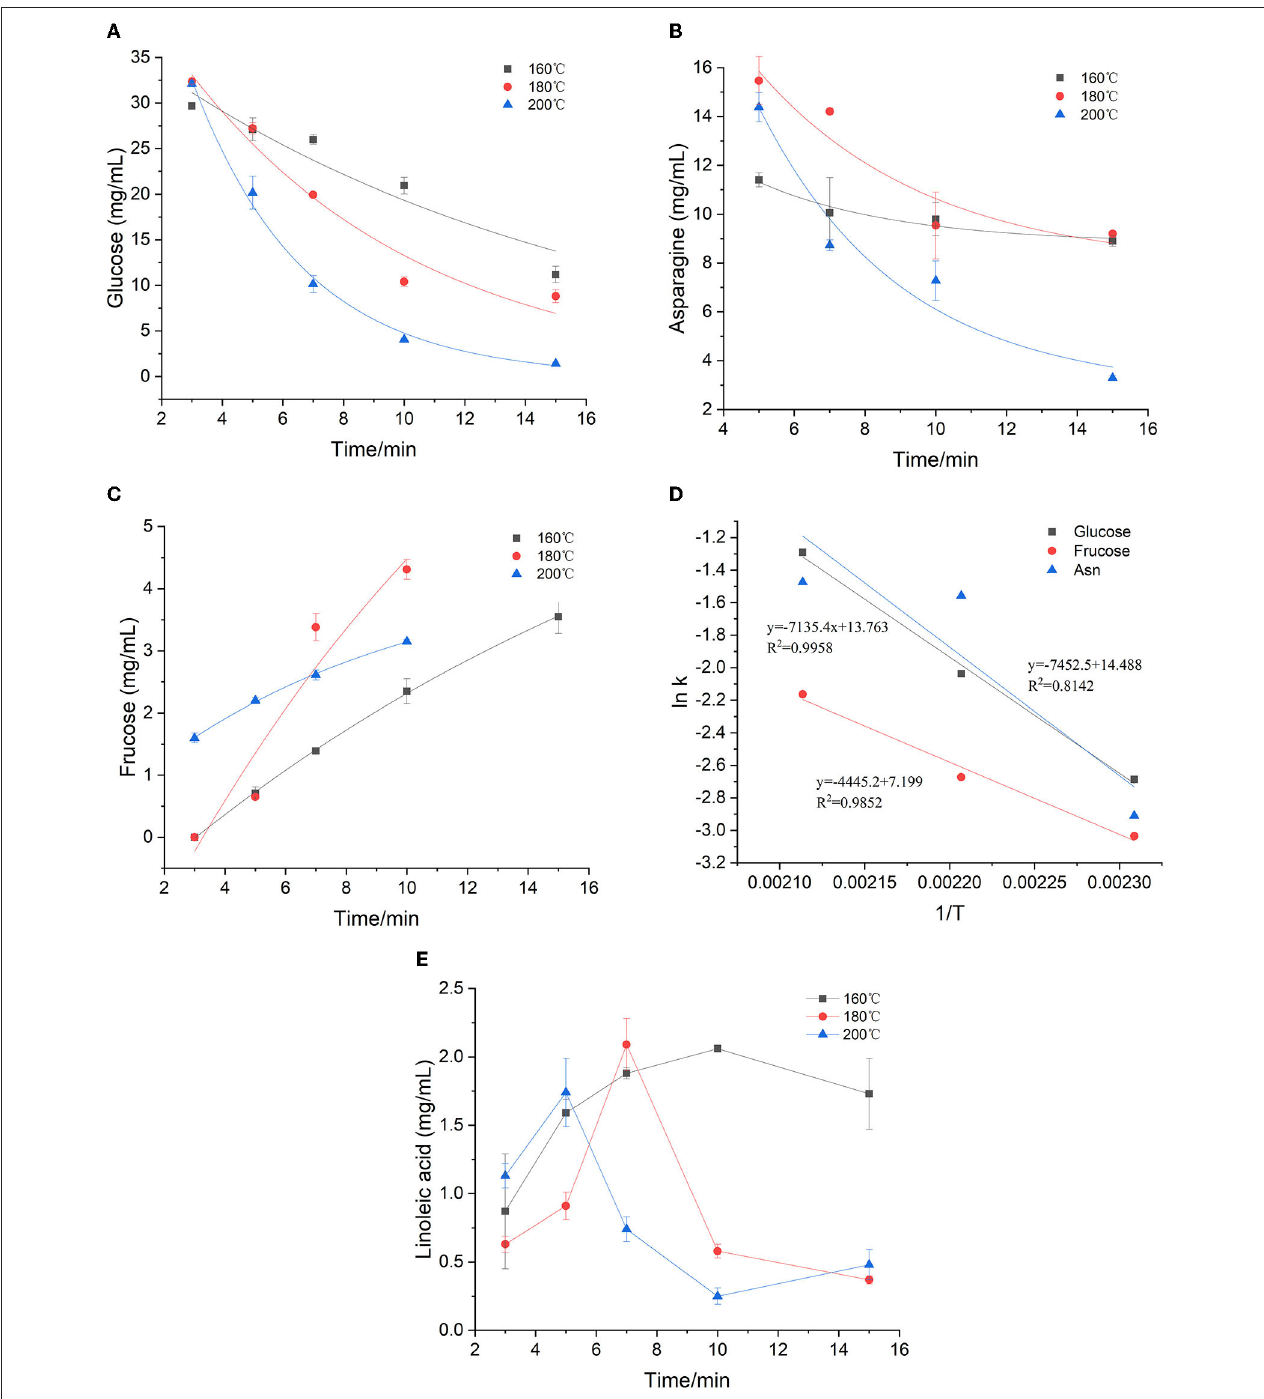
FIGURE 1 | Kinetic changes of precursors in heated model system (A) glucose, (B) asparagine, (C) fructose, (D) Arrhenius plot and (E) Effect of time and temperature on linoleic acid concentration. of asparagine from the initial condensation product (such as the Amadori rearrangement product) and the possible formation of diglucosamine